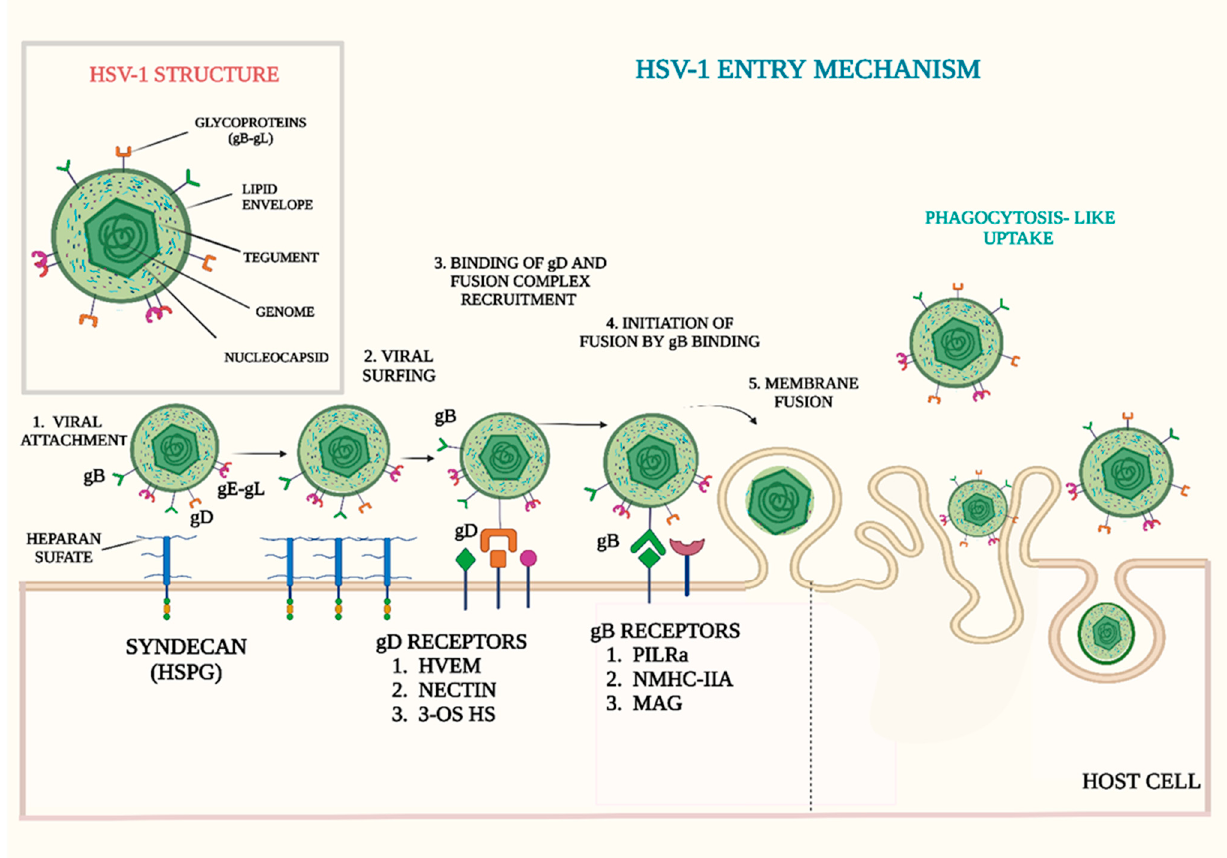
Figure 1. HSV-1 ENTRY MECHANISMS. Top right: HSV-1 structure constitutes outer lipid envelope that contains 12 glycosylated (gB, gC, gD, gE, gG, gH, gI, gJ, gK, gL, gM, gN) and three unglycosylated (UL20, UL45, US9) proteins, inner tegument proteins and nucleocapsid enclosing genome. Bottom center: HSV-1 entry requires receptor-binding glycoprotein gD, the heterodimer gH/gL, and the fusogen gB. Different glycoproteins utilize different host receptors such as gD receptors (HVEM, herpes virus entry mediator, Nectin-1), 3-OS-HS, 3-O-sulfated-heparan sulfate, gB receptors (PILR α , paired immunoglobulin-like type 2 receptor alpha, NMHC-IIA, non-muscle myosin II, MAG, myelin associated glycoprotein) for entry and cell to cell spread. gC makes the first contact with the host cell, binding to heparan sulfate (HS) proteoglycans on the cell surface. In some cases, HSV-1 travels down filopodia-like membrane protrusions to reach the cell body for internalization. This extracellular transport of virions is called “surfing”. The glycoprotein gB regulate viral surfing, as it binds to the HS attached to the syndecan (HSPG). Once the virus is bound, it travels unilaterally to the cell surface, where gD proceeds to bind with one of its four receptors (discussed above) and the process of virus penetration and membrane fusion ensues, or the virus can enter the cell by phagocytosis-like uptake [Created in bioRender].